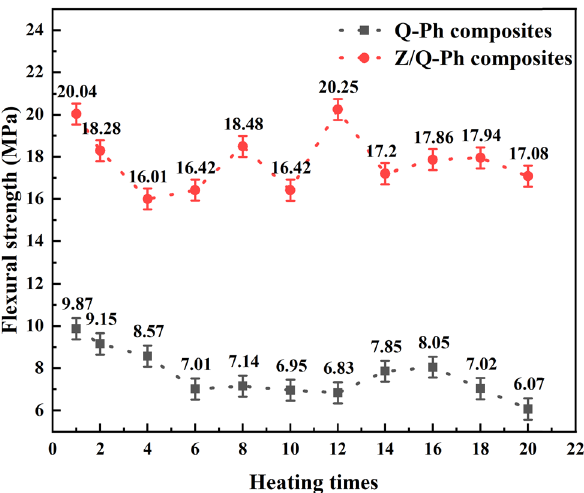
Figure 7: Mechanical properties of Q – Ph composites and Z/Q – Ph composites after di ff erent heating